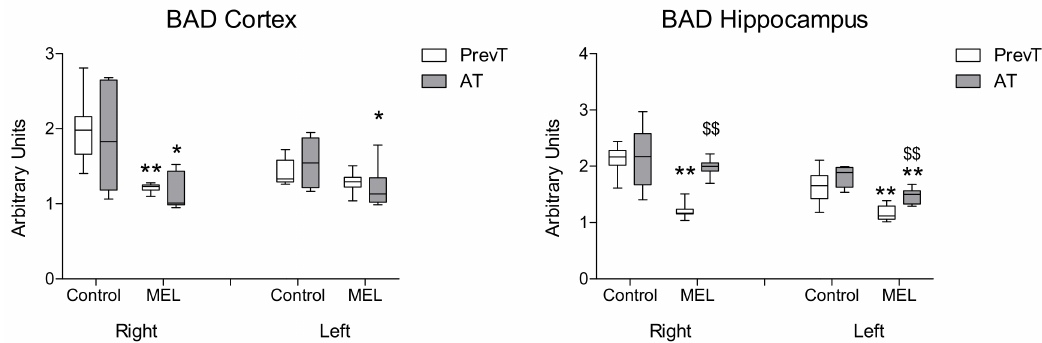
Figure 4. Right and left cortical and hippocampal mRNA expression of BAD in 18-month-old rats in control (non-treated) conditions, after treatment with a daily dose of melatonin (10 mg/kg b.w.) from 24 h before until 7 days after surgery (PrevT), and treated only after surgery during 7 days (AT). Each value represents the median, interquartile and full range of five determinations performed in duplicate. * p < 0.05 with respect to the values obtained in the control group; ** p < 0.01 with respect to the values obtained in the control group; $$ p < 0.01 with respect to the values obtained in the PrevT